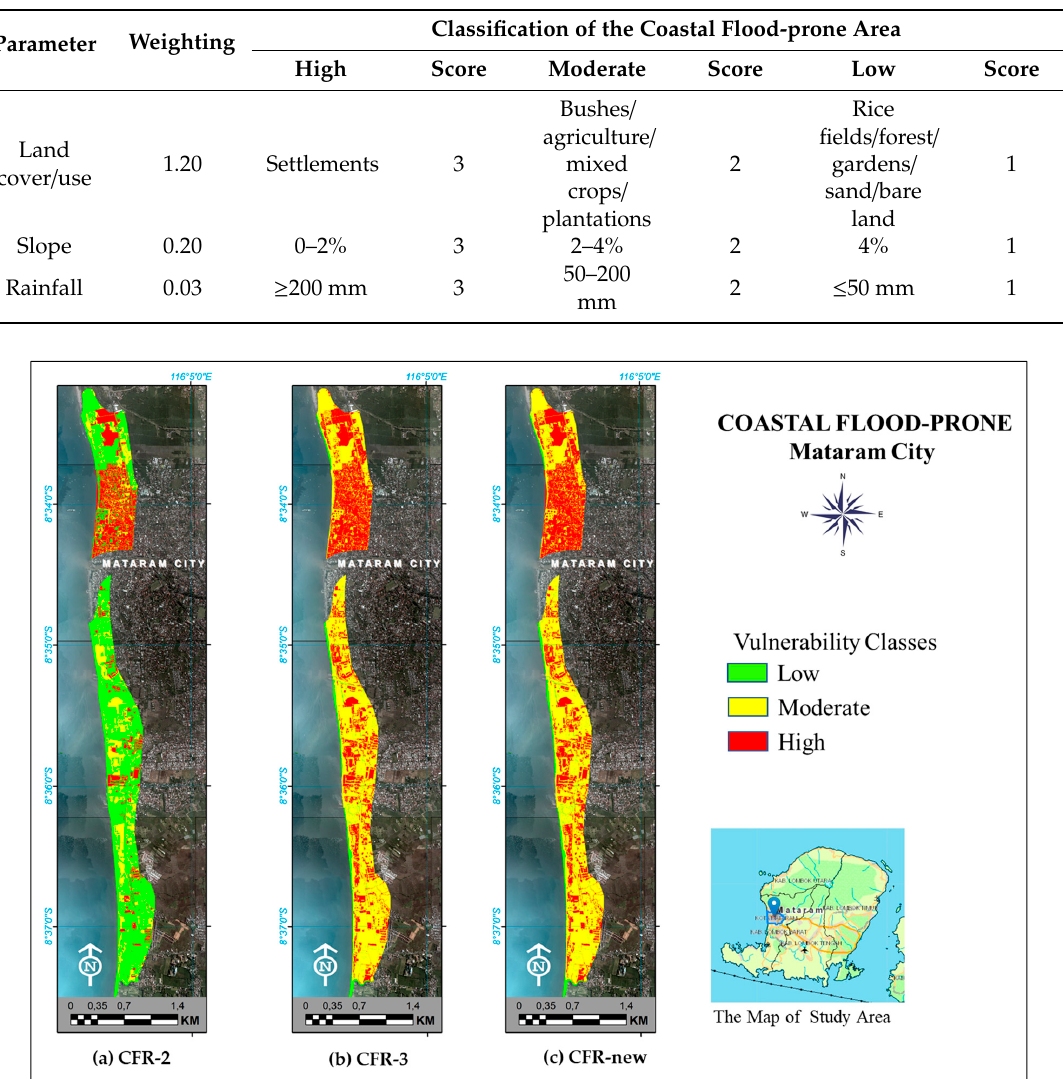
Table 4. Matrix of the MCE for the CFR-new.